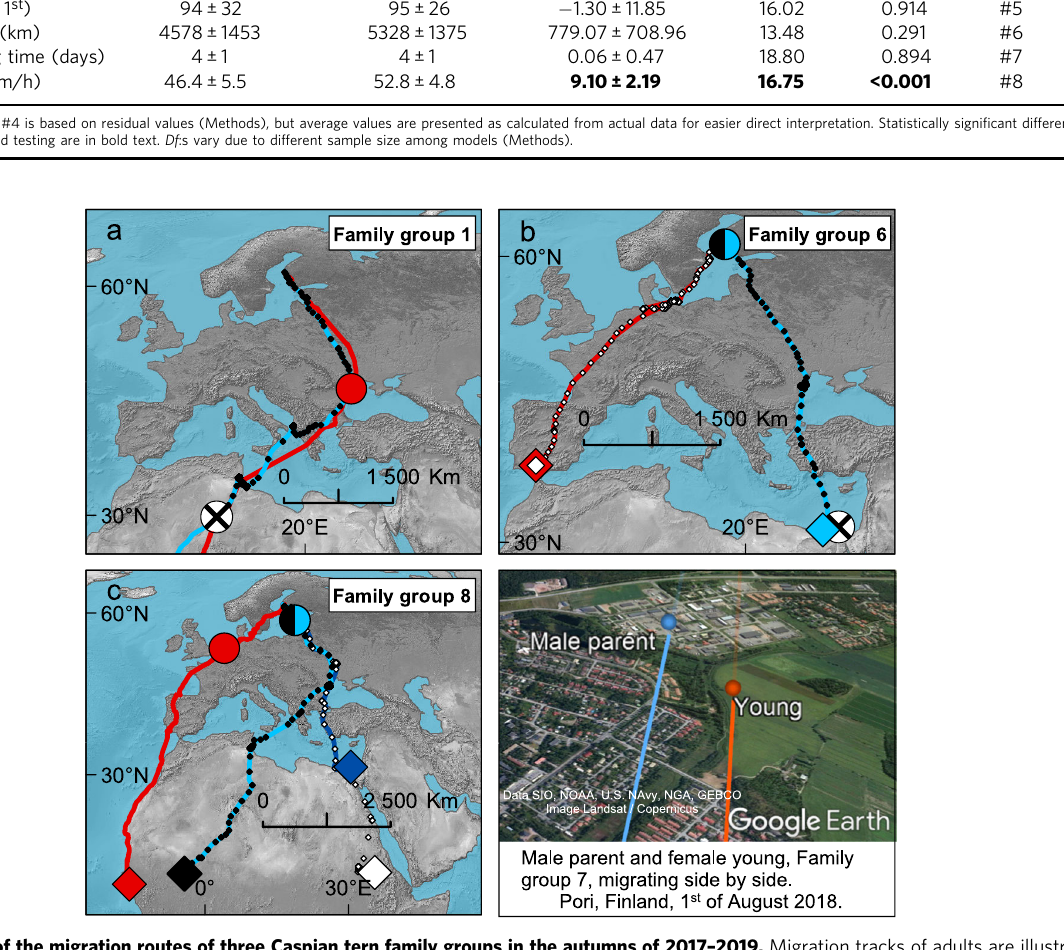
Fig. 1 Examples of the migration routes of three Caspian tern family groups in the autumns of 2017 – 2019. Migration tracks of adults are illustrated as continuous lines (red: Female parent, light blue: Male parent, dark blue: Foster male parent), that of young as diamonds (black: Young 1, white: Young 2). Large intact/split circles indicate geographical locations of tracked birds (as identi fi ed by their respective colours) when a , single, or b and c , the latter young (Young 2) from families of two young initiated migration together with the parent, i.e. they indicate the location of the other family member(s) when the last members from the same family group initiated migration. Crossed circles indicate locations of death/tag failure. Large diamonds indicate geographical location of birds on December 31 st . For more details on symbology and family groups, see Supplementary Table 1 and Supplementary Fig. 1. A snapshot of an animation of real data (Supplementary Movie 1) showing the male parent and young from Family group 7 migrating side by side over Pori, Finland, is included in the bottom right-hand